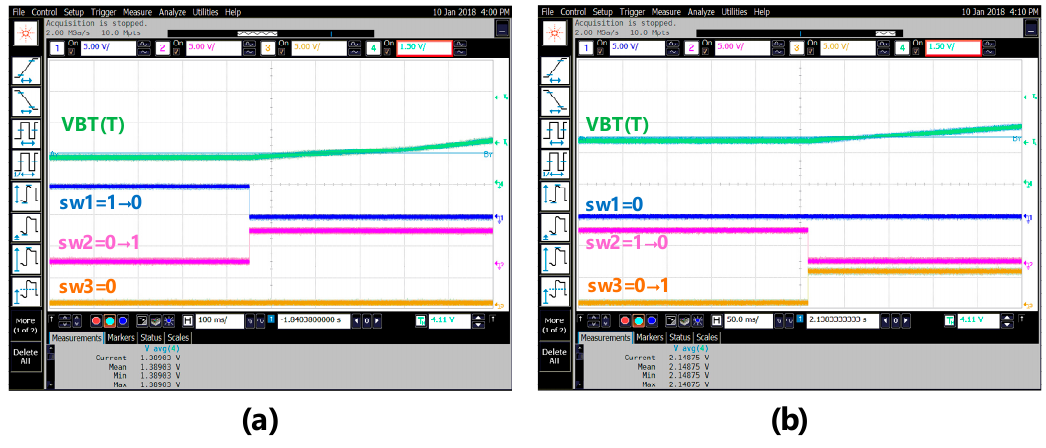
Figure 11. The scenario of three switches when the ambient temperature ( a ) 70–65 °C and ( b ) 30–25 °C.